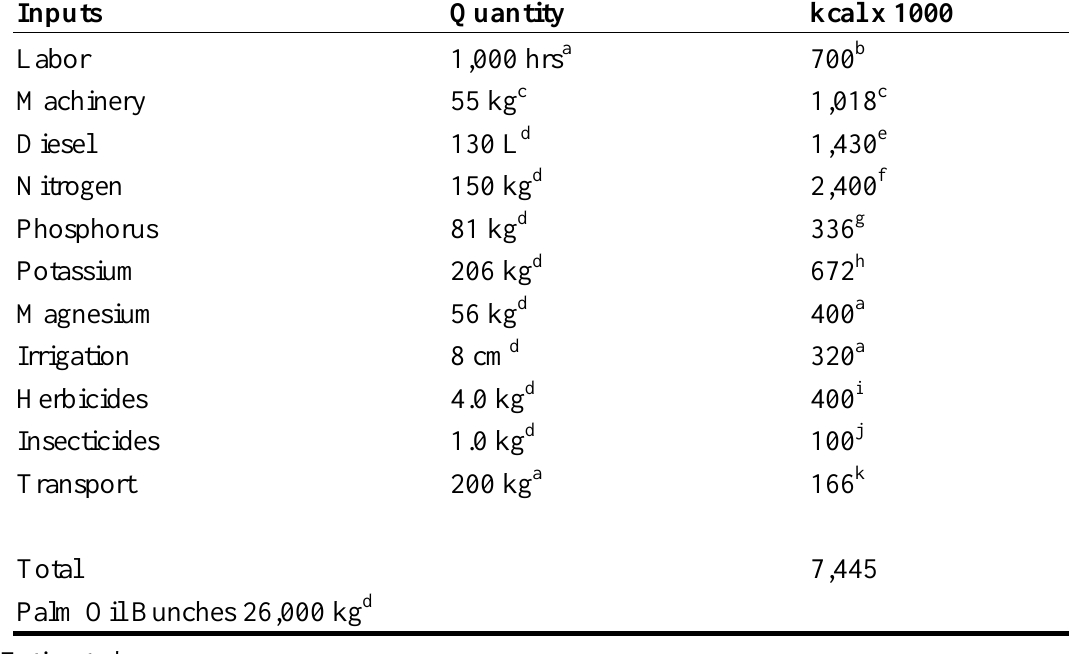
Table 12. Energy inputs for palm oil production in Thailand and